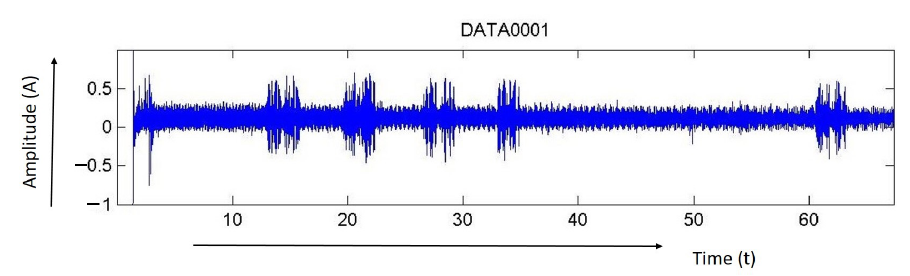
Figure 3. Threshold setting for noise removal (threshold level =